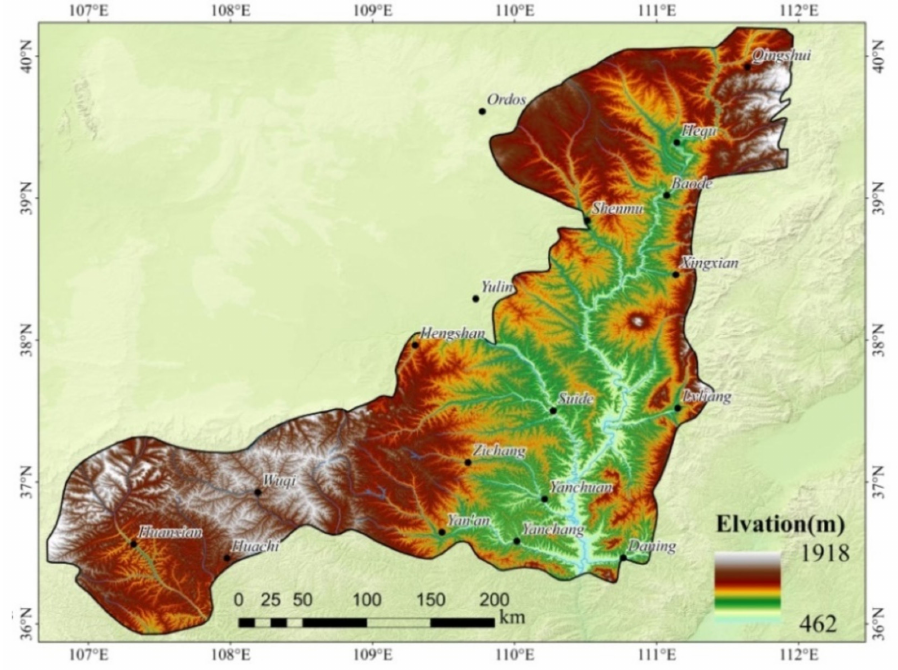
Figure 4. The DEM map of underlying